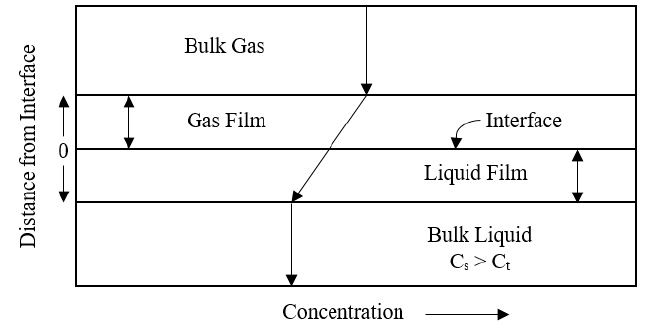
Figure 3. Two Film theory (absorption of gas molecule).